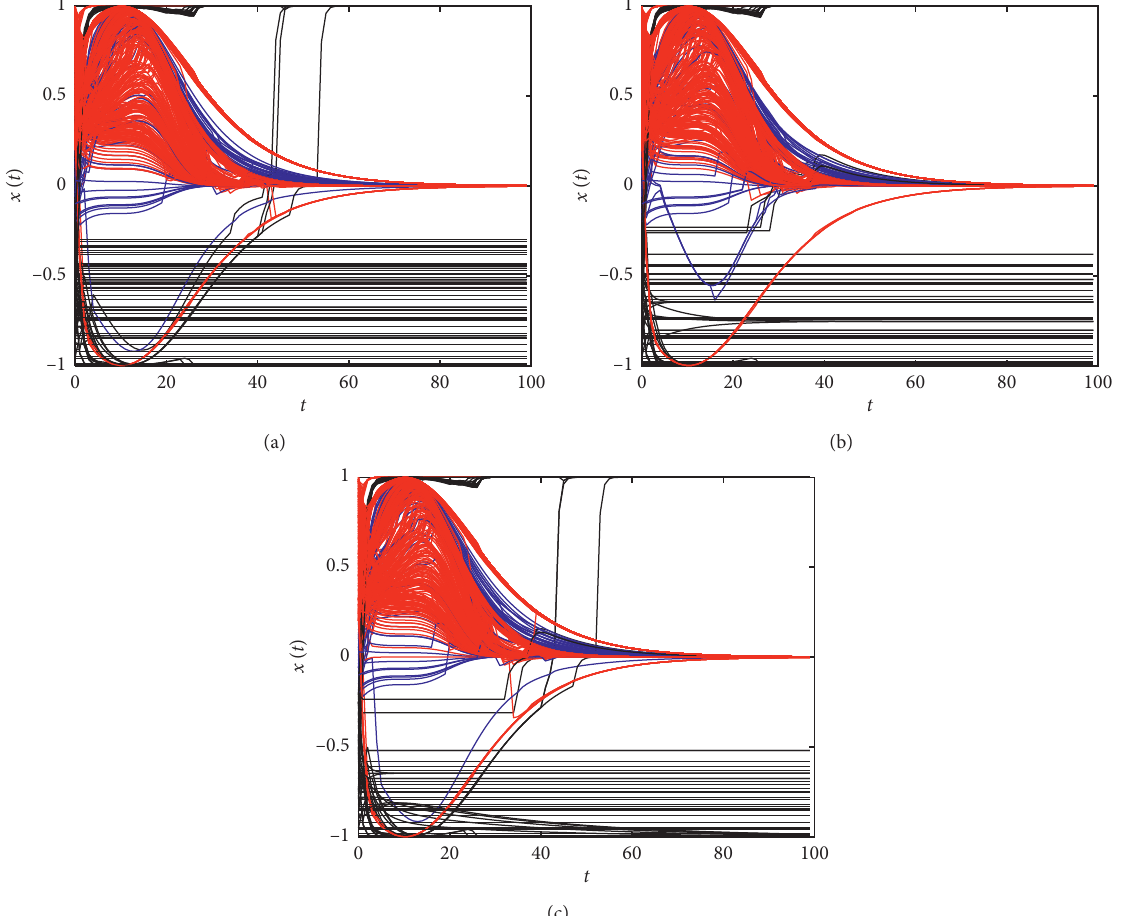
Figure 13: Impact of centrality approach on individual opinion reversal: (a) centrality; (b) closeness centrality; (c) betweenness centrality.